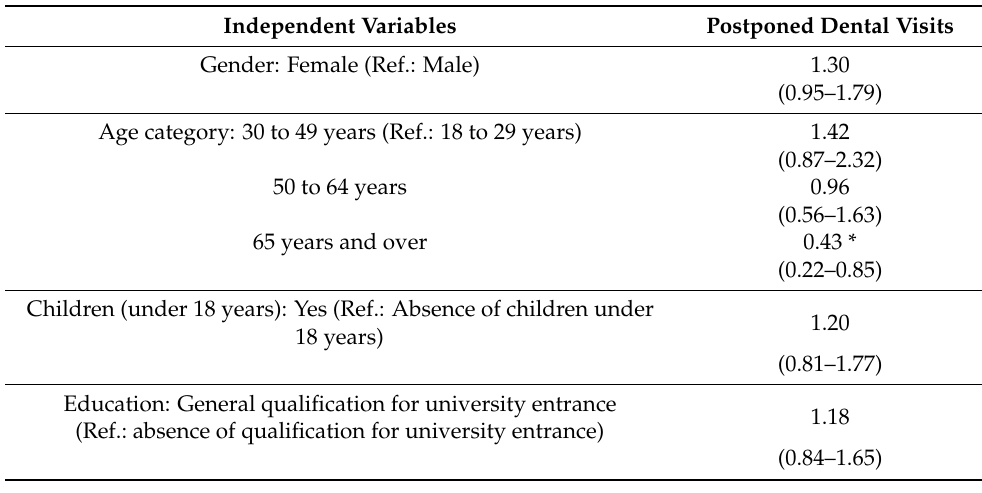
Table 2. Determinants of postponed dental visits (0 = no, not postponed; 1 = yes, postponed) due to the COVID-19 pandemic since March 2020. Findings of multiple logistic